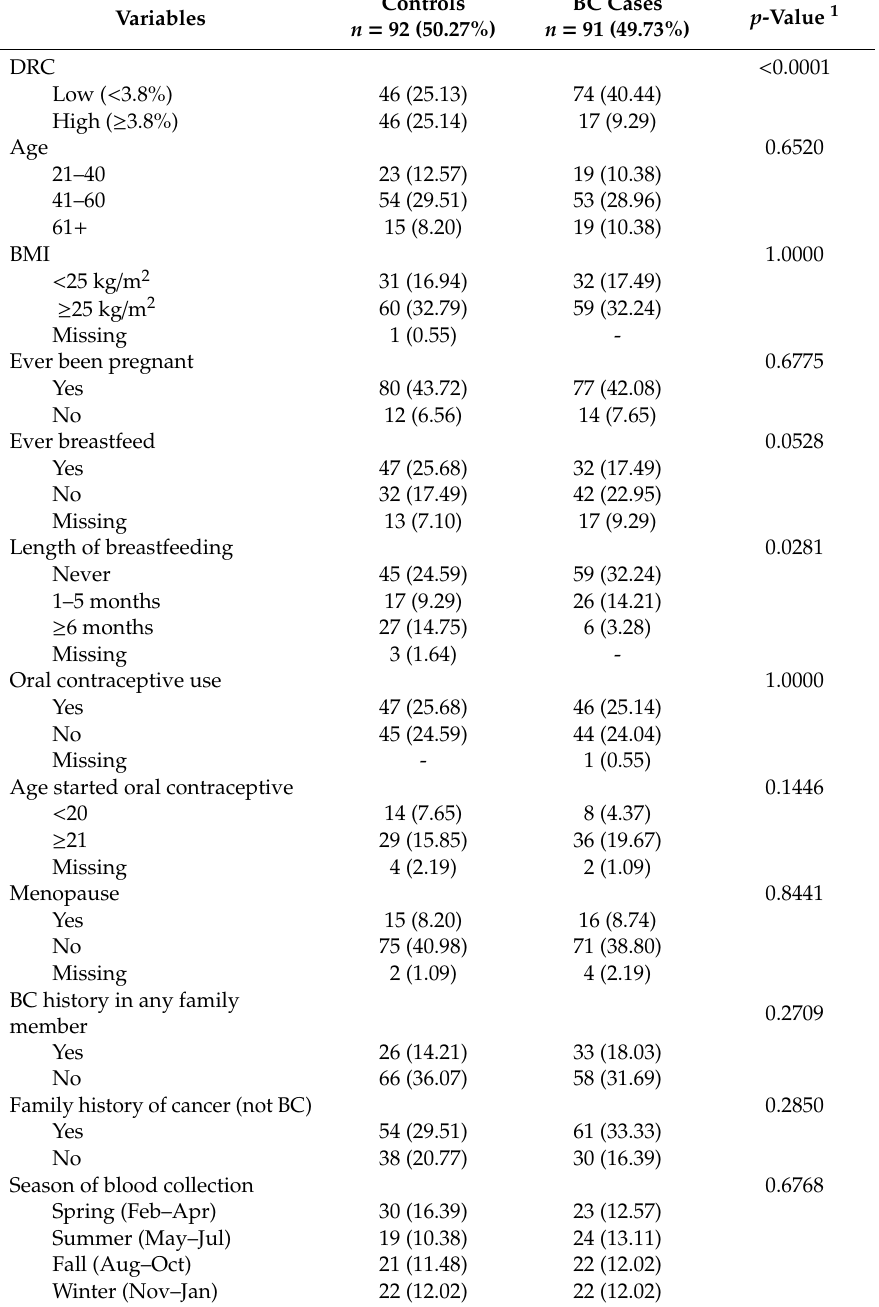
Table 1. Description of the study population including women with and without breast